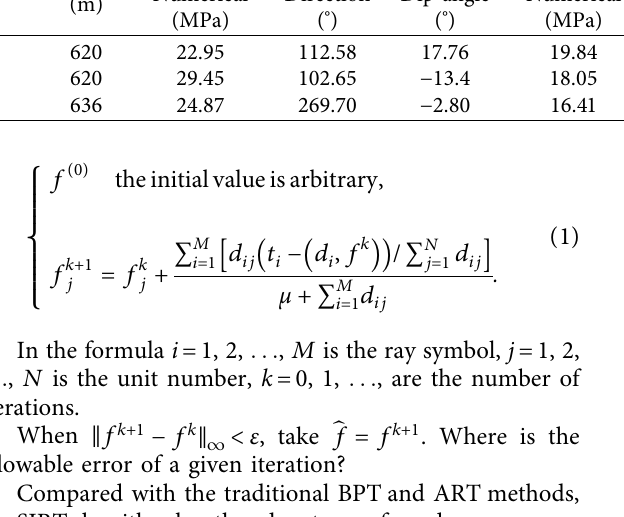
Table 3: Calculation results of principal stress at each measuring point of Bayangaol mine. Depth Point